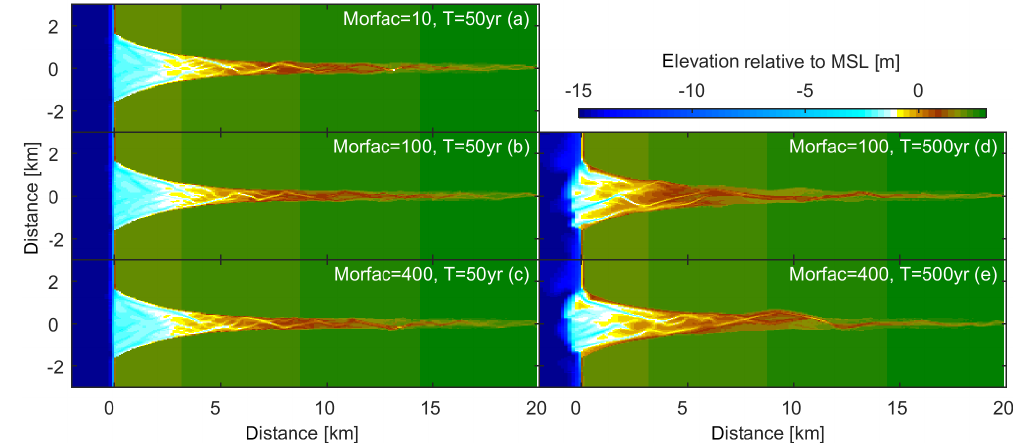
Figure A13. Resulting bathymetries from runs with different morphological acceleration factors of (a) 10, (b–c) 100 and (d–e) 400 after (a, b, d) 50 and (c, e) 500